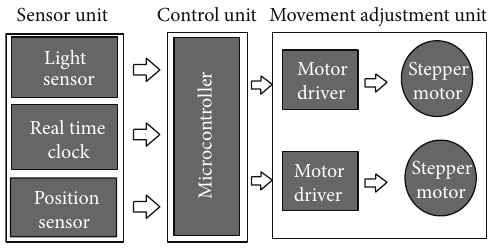
Figure 6: Block diagram of the electrical circuit.